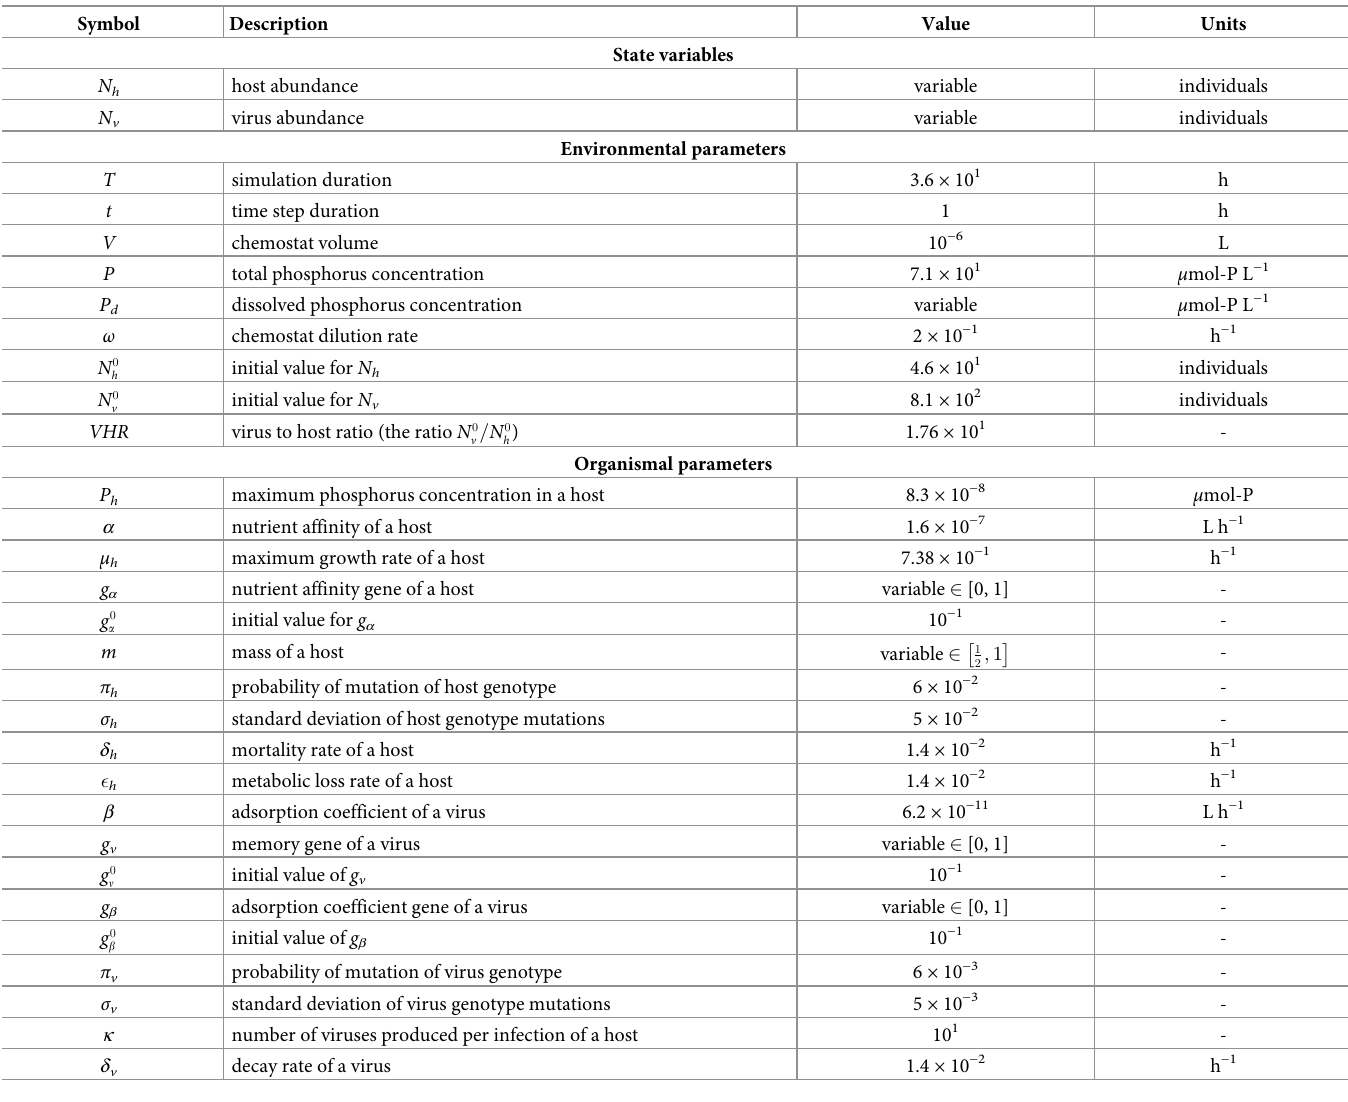
Symbol, description, typical value [21], and